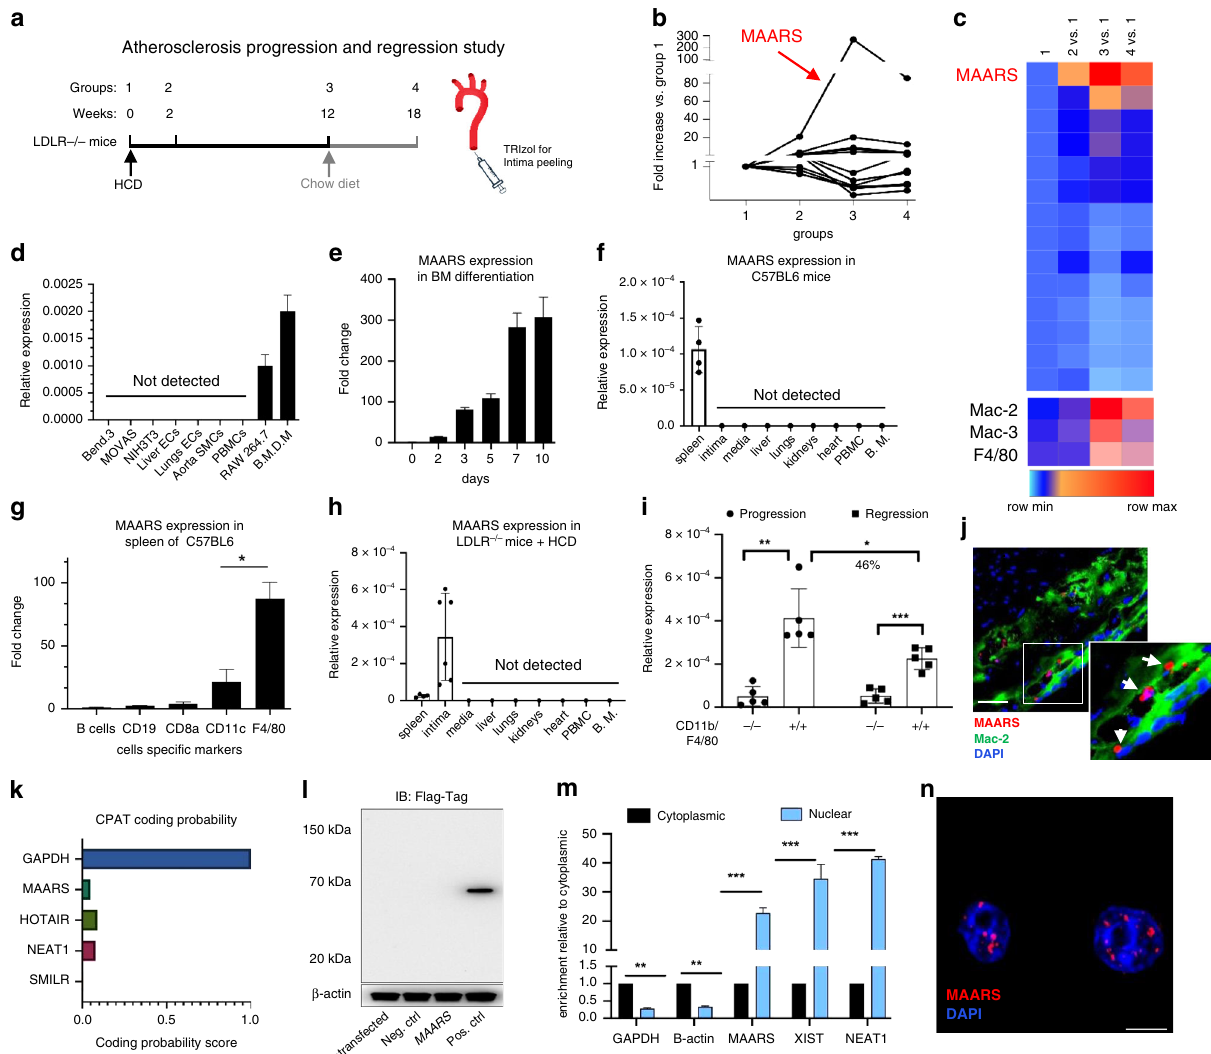
Fig. 1 Identi fi cation of the lncRNA MAARS in lesional intima. a RNA derived from aortic intima of LDLR − / − mice ( n = 3; each sample represents RNA pooled from two mice) that were placed on an HCD for 0 weeks (group 1), 2 weeks (group 2), 12 weeks (group 3), and 18 weeks after 6 weeks of resumption of a normal chow diet (group 4). b RNA-Seq results for 11 lncRNA hits obtained by DESeq2/NOR analysis and expressed as fold change compared to group 1 ( n = 3). c Heatmap for 11 lncRNAs that were dynamically regulated with progression and regression of atherosclerosis and expression of macrophage markers Mac2, Mac3, and F4/80, as compared to group 1 ( n = 3). d RT-qPCR expression analysis for MAARS in different cell types ( n = 3). e MAARS expression kinetics in macrophages differentiated from bone marrow ( n = 3). f MAARS expression in body organs and PBMCs of 24 weeks old C57BL/6 mice ( n = 4, left panel). g MAARS expression in C57BL6 spleen fractions isolated with magnetic beads speci fi c for different cell types ( n = 3): F4/80 (macrophages), CD8a (T cells), CD11c (dendritic cells), CD19 (B cells), and negative selection for B cells. h MAARS expression in body organs and PBMCs of 24 weeks old LDLR − / − mice fed with high cholesterol diet (HCD) for 12 weeks ( n = 5). i MAARS expression in 50,000 cells FACS sorted for F4/80- and CD11b-negative or double-positive cells isolated from aorta of ApoE − / − mice fed HCD for 12 weeks (progression) and 18 weeks after 6 weeks of resumption to a normal chow diet (regression) ( n = 5). j RNA - in situ hybridization for MAARS -probe (red), Mac-2 (green), and DAPI (blue) staining in the aortic lesions of LDLR − / − fed HCD for 12 weeks. k Coding potential assessing tool (CPAT) predicts very low coding potential for MAARS lncRNA. l To test the coding potential, MAARS sequence was cloned upstream of 3xFlag-Tag cassette, transfected in 293 T cells, and immunoblotted for Flag antibody. Positive control was provided with the kit ( n = 3 experiments). m RT-qPCR analysis for RNA derived from BMDMs separated into cytoplasmic and nuclear fractions and normalized to the cytoplasmic fraction ( n = 3). n RNA - in situ hybridization for negative control- and MAARS -probes on PFA- fi xed BMDMs. For all panels, values are mean ± SD; * p < 0.05; ** p < 0.01; *** p < potential, MAARS sequence was cloned upstream of the Supplementary Fig. 1e). MAARS is highly expressed in BMDMs p3xFLAG-CMV plasmid, transfected in HEK293 cells, and with 9.84 × 10 8 copies ng − 1 of RNA and is expressed 2.4-fold higher than the regularly used housekeeping gene hypoxanthine immunoblotted for FLAG Tag, which showed no detectable phosphoribosyltransferase 1 (HPRT) (Supplementary Fig. 1h). peptide or protein (Fig. 1l). In addition, MAARS is polyadeny- Collectively, these results indicate that MAARS is a macrophage- lated (Supplementary Fig. 1g) and enriched in the nucleus of the and nuclear-speci fi c lncRNA markedly induced with athero- macrophages as observed by cell fractionation (Fig. 1m) and by sclerotic progression. RNA-ISH in bone marrow-derived macrophages (Fig. 1n and